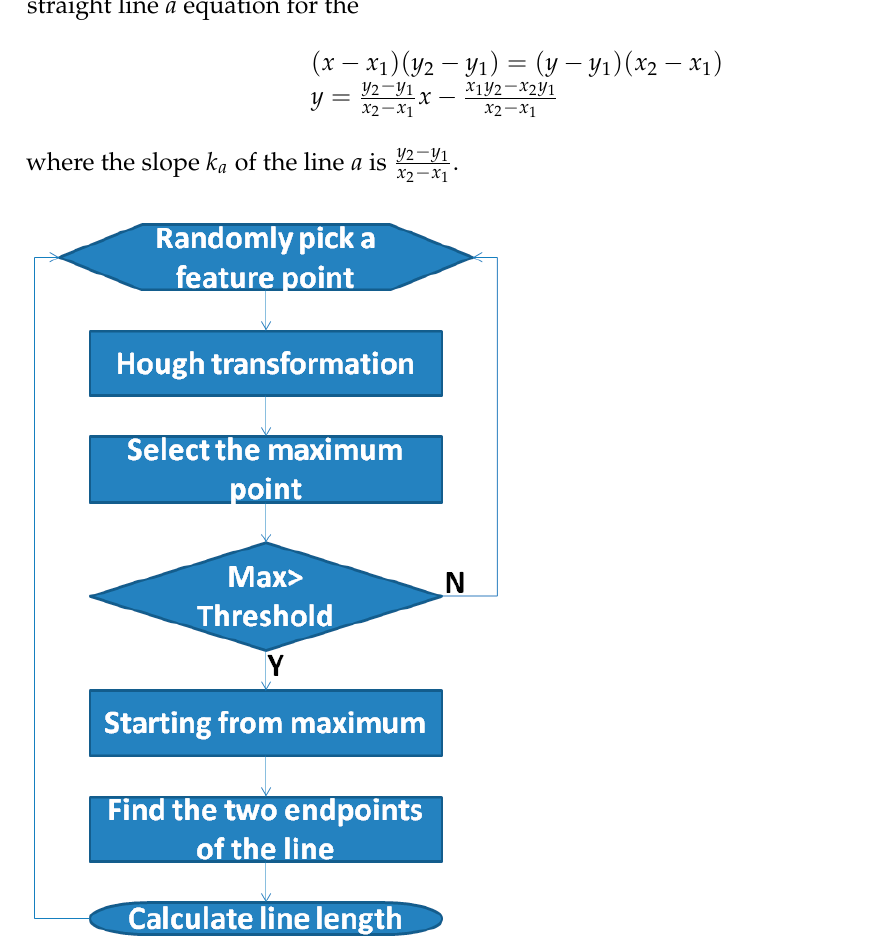
Figure 10. Estimating the length of negative obstacles.